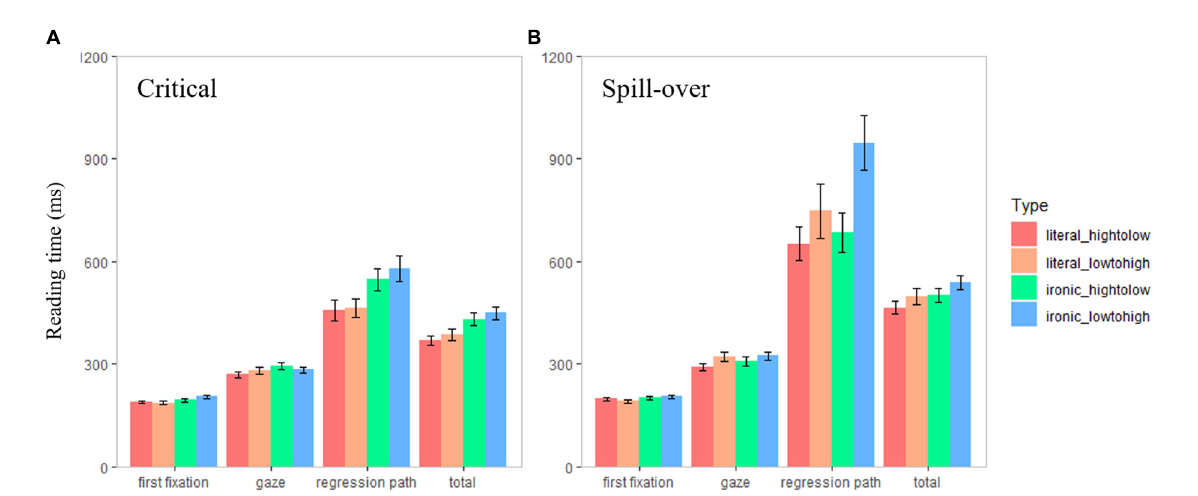
FIGURE1 Reading times for the literal and ironic expressions in high-to-low or low-to-high conditions in critical (A) and spill-over (B) regions. The x-axis represents the reading time measures and conditions, and the y-axis represents the mean value of reading times (in milliseconds). The error bar shows the standard error.